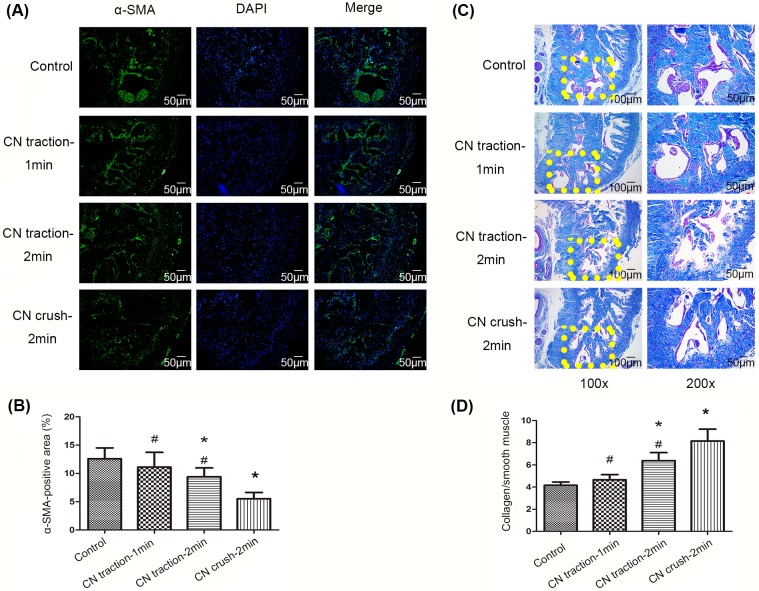
Changes of smooth muscle and collagen content in corpus cavernosum.(A) Smooth muscle staining (green) in corpus cavernosum in each group using immunofluorescence with anti-α-smooth muscle actin (α-SMA) antibody. Nuclei were stained with DAPI (blue). Magnification: 200×. (B) Ratio of α-SMA positive area to the whole cavernous tissue area. Data are shown in the form of percentage. (C) Masson’s trichrome staining of corpus cavernosum: smooth muscle cells are stained red, and collagen fibers are stained blue. (D) Ratio of collagen to smooth muscle, reflecting the level of fibrosis in penile tissue. N = 6 in each group. * P<0.05 compared with control group. # P<0.05 compared with 2-min CN crush group.